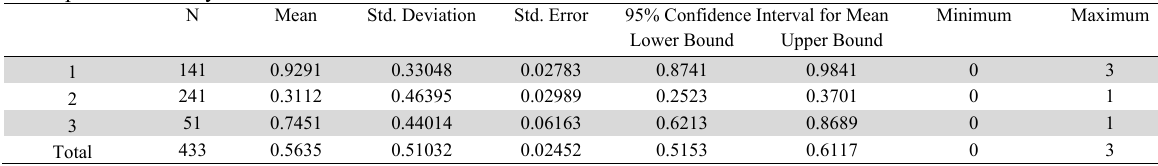
Results of Analysis of Variance for faculty Between Groups Within Groups